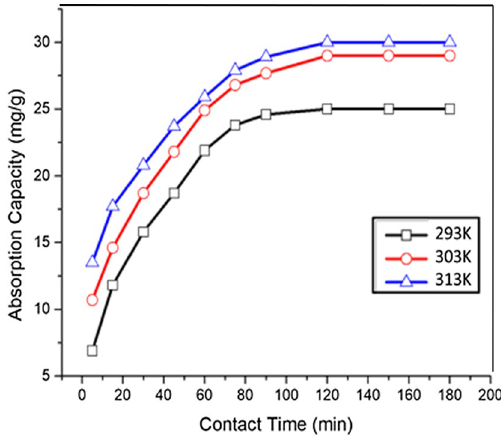
Fig. 6 Effect of Temperature on adsorption capacity